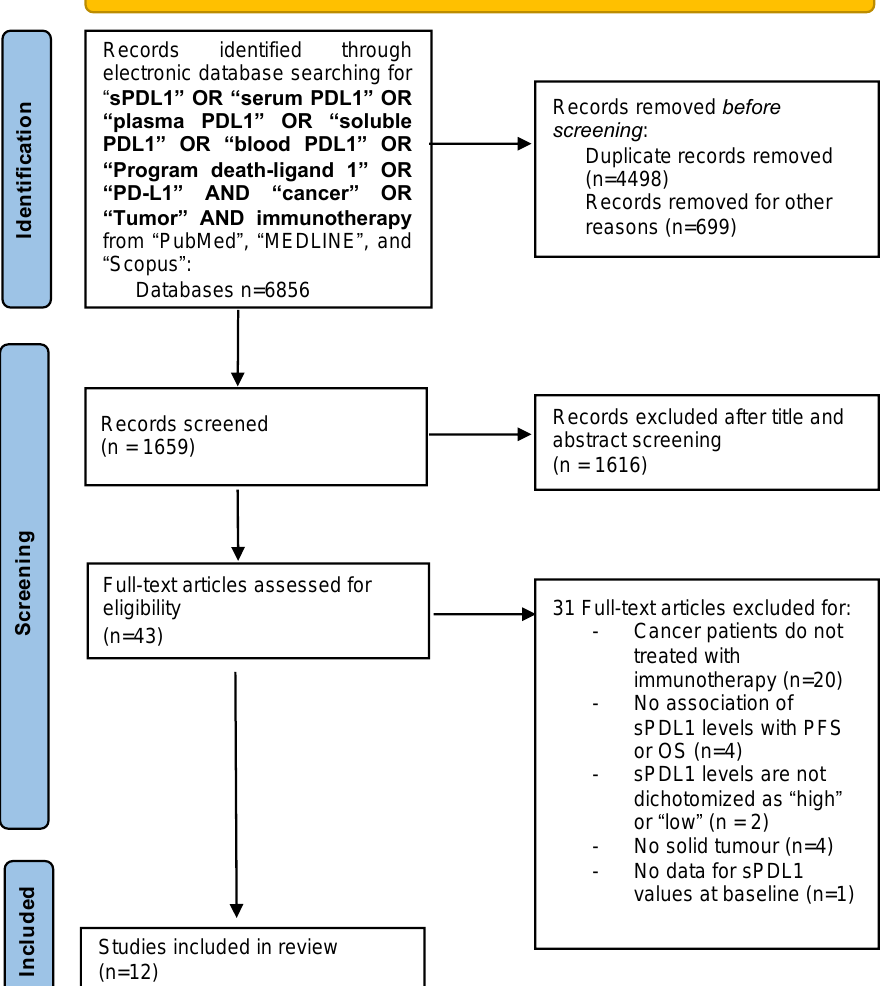
Figure 1. Flow chart of the study selection process.